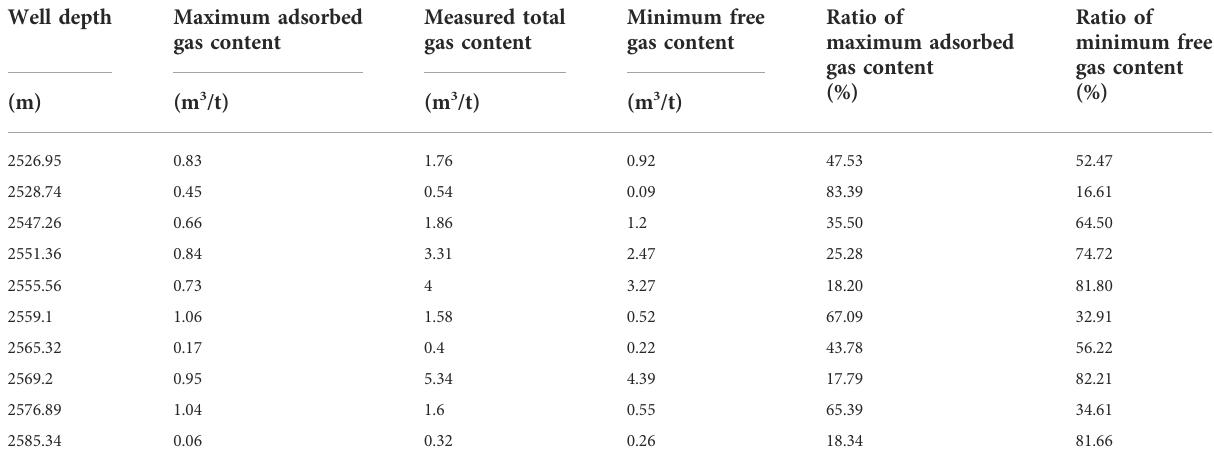
TABLE 3 Ratios of minimum free gas content and maximum adsorbed gas content to total shale gas content and calculation results of minimum free gas content. Well